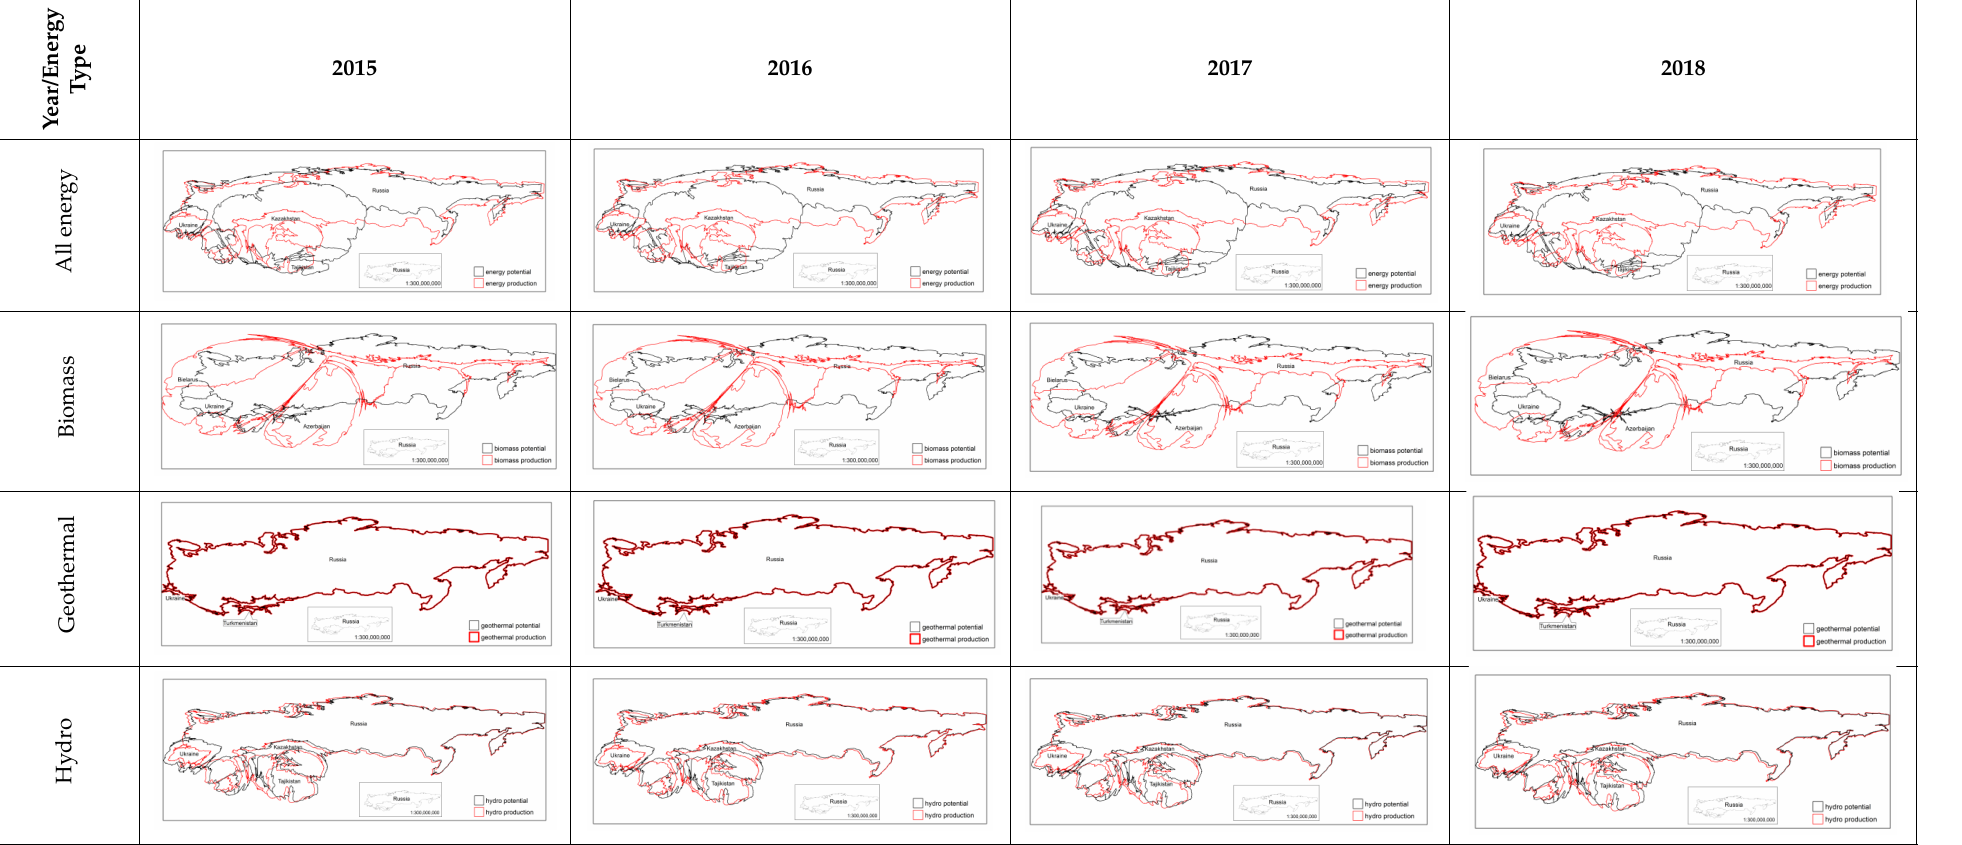
Table 4. The RES potential and production matrix of the Commonwealth of Independent States in